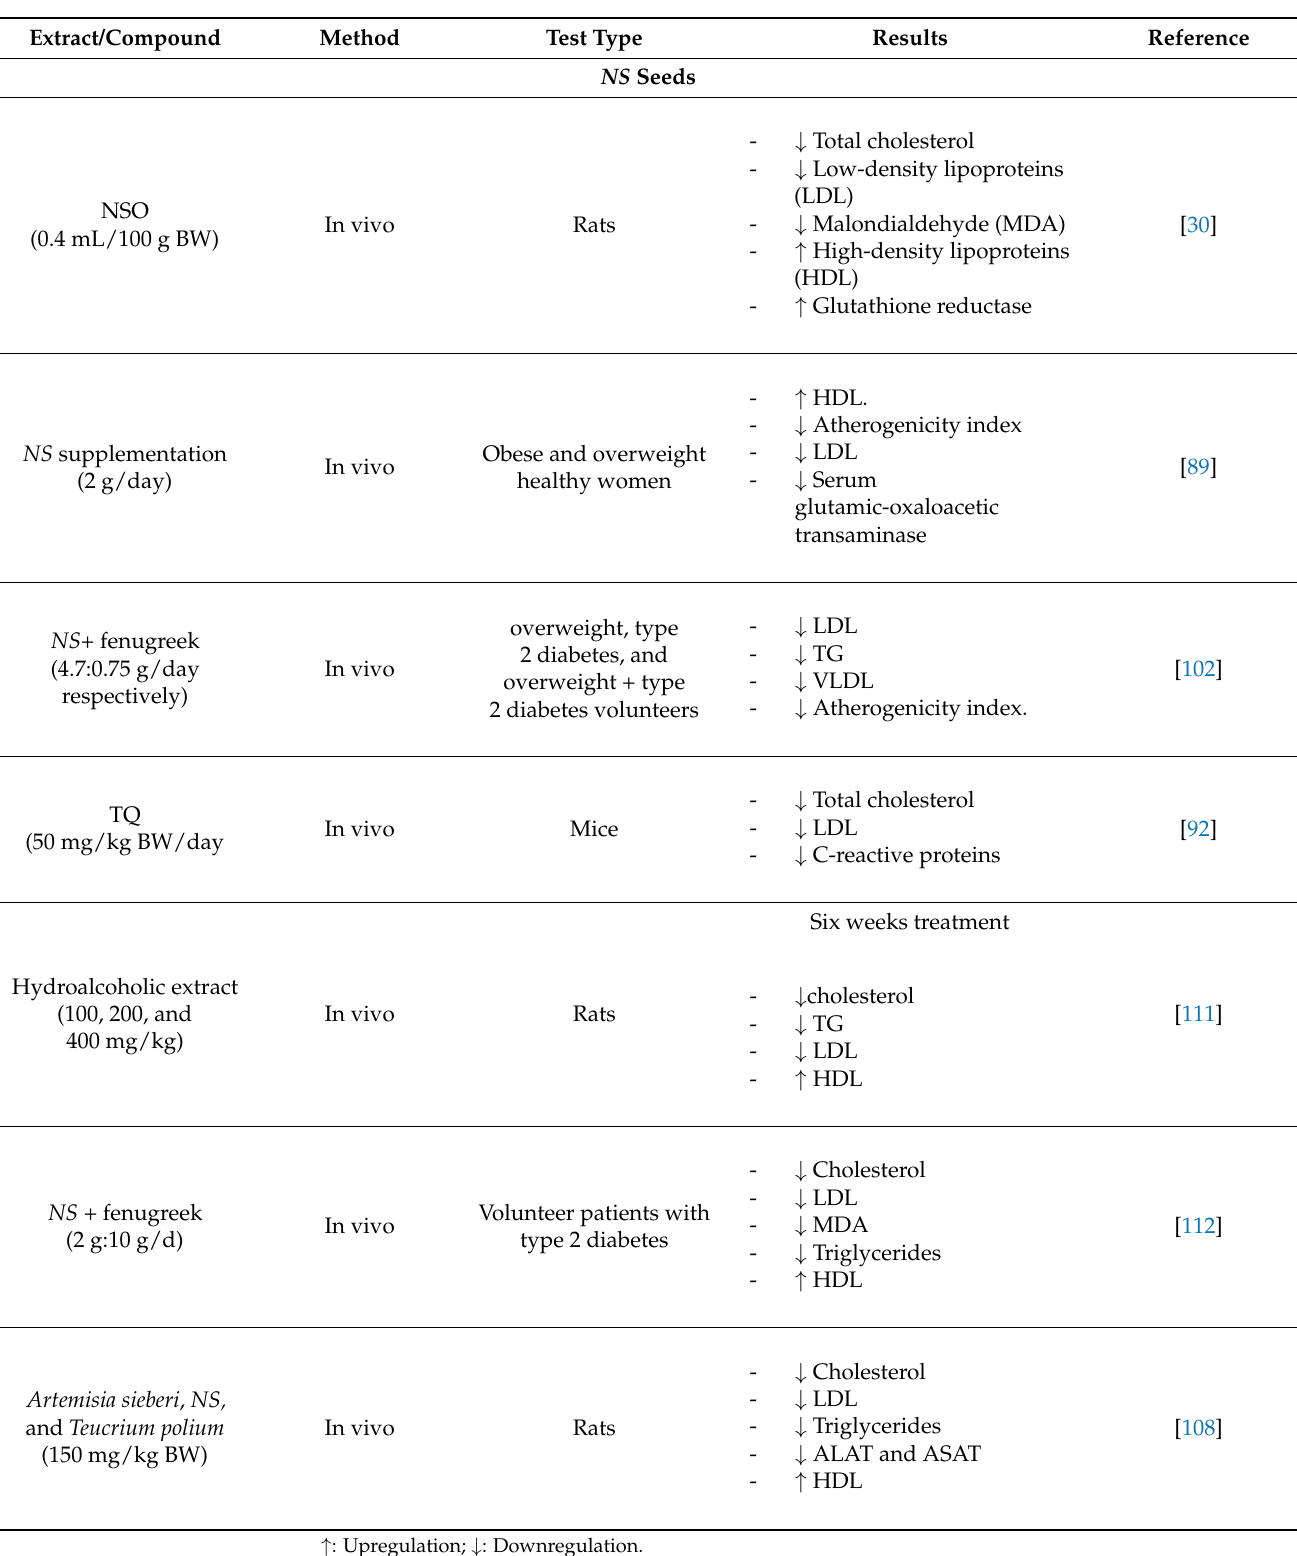
Table 7. Summary of the hypolipidemic activities of